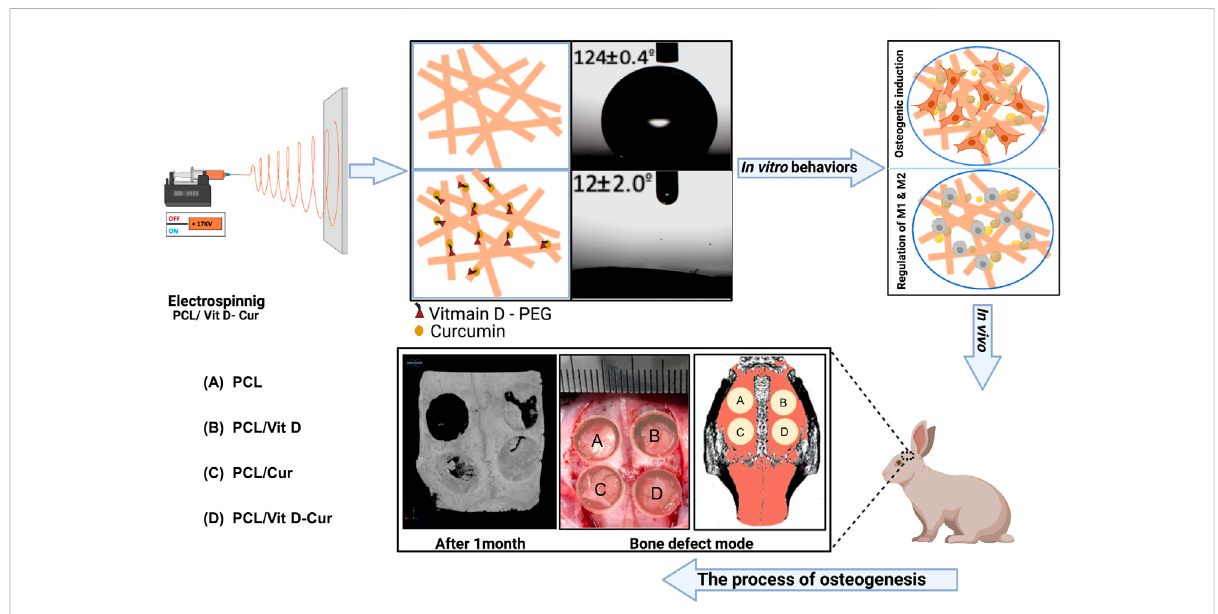
FIGURE 1 Graph of scaffold fabrication and use for enhancing the anti-in fl ammatory and bone formation in vitro and in vivo : (A) PCL, (B) PCL/Vit D, (C) PCL/Cur, and (D) PCL/Vit D-Cur.